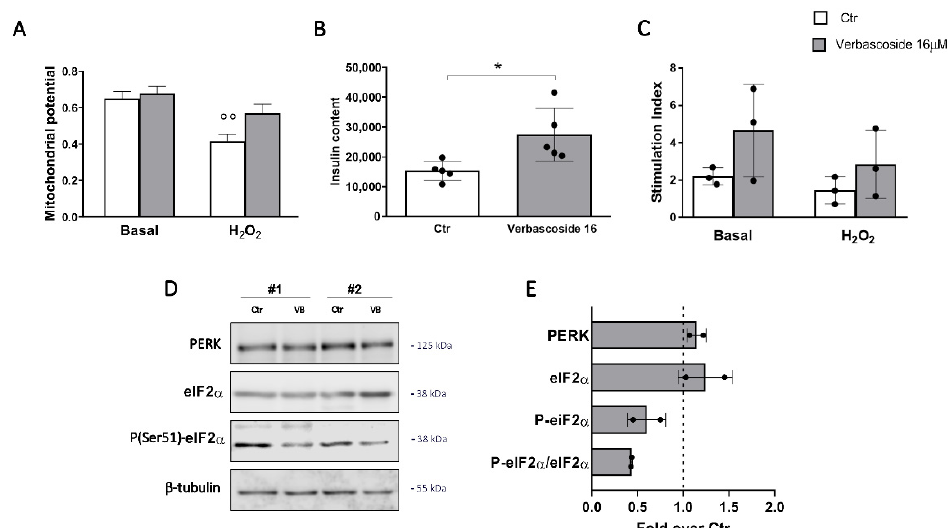
Figure 5. Verbascoside improves human islets of Langerhans function. Islets were incubated with or without 16 µ M verbascoside for 5 days. ( A ) Mitochondrial membrane potential. Human islets were loaded with 100 nM MitoSpy ™ Orange CMTMRos and 100 µ M MitoSpy ™ Green FM and the mitochondrial membrane potential and mass were measured by fluorimetry (551 / 576 nm Ex / Em and 490 / 516 nm Ex / Em, respectively). The bar graph illustrates the average responses ± SD, data were normalized to the mitochondrial mass (Two-way ANOVA, post-hoc Tukey’s test, ◦◦ p = 0.0013 H 2 O 2 vs. Basal). ( B ) The insulin content was evaluated by ELISA assay. Data (mean ± SD) are expressed as mU insulin / g protein (n = 5 independent experiments; Student’s t -test, * p < 0.05 VB vs. Ctr). ( C ) The insulin release in basal (3.3 mM glucose) and stimulated (16.7 mM glucose) conditions were measured by ELISA assay and data (mean ± SD; n = 3 independent experiments) are expressed as stimulation index (stimulated / basal insulin release). ( D ) Western blot analysis of ER stress markers in islets treated with 16 µ M verbascoside (VB) for 5 days (15 µ g protein / sample). On the right, the molecular-weight size markers in kDa are reported. ( E ) The quantitative analysis shows a trend toward decrease of P-eIF2 α expression and P-eIF2 α / eIF2 α ratio. Data (mean values ± SD) are expressed as fold change over control (dashed line). (n = 2 di ff erent islets isolation, performed in